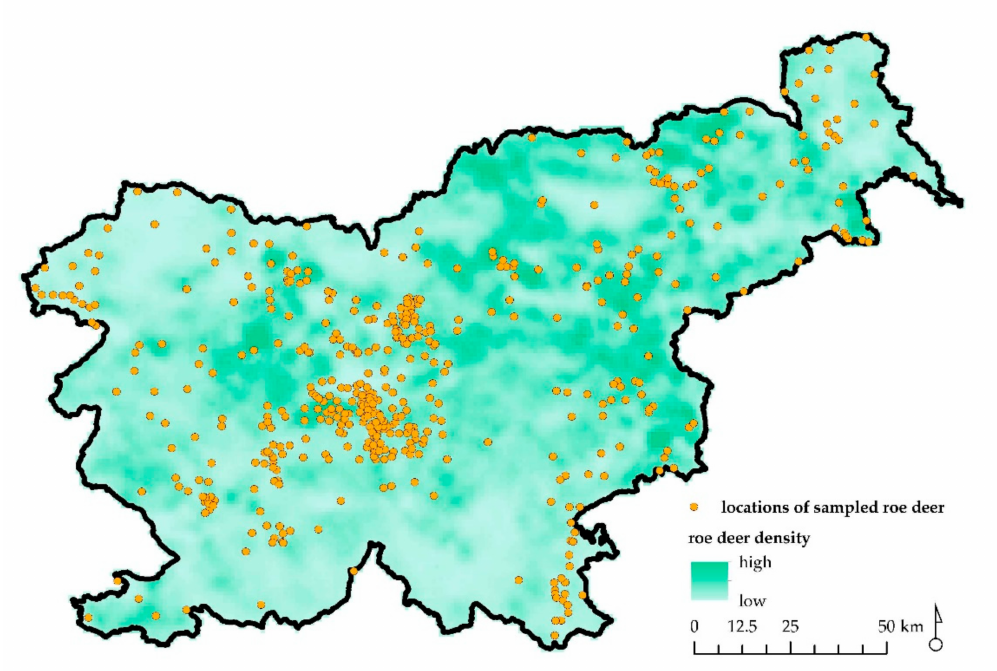
Figure 2. Map of Slovenia with depicted locations of sampled and analyzed free ranging roe deer ( n = 510; orange dots) and roe deer relative population density (lowest to